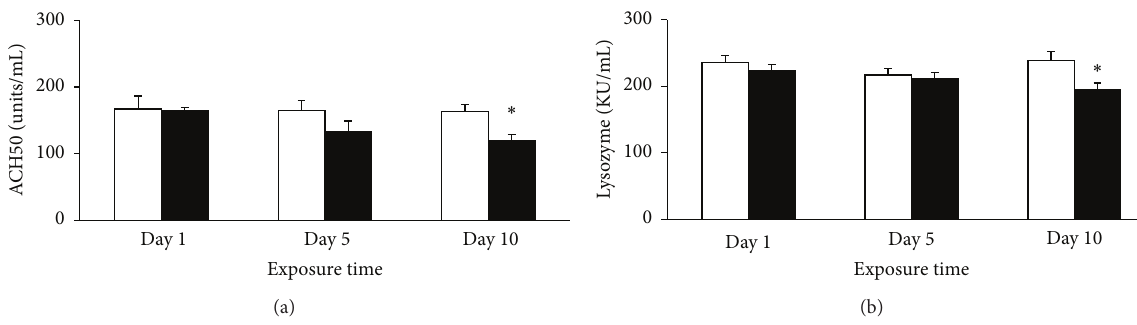
Figure 1: Plasma complement ACH50 (a) and lysozyme (b) activities of O. mykiss 1, 5, and 10 days after ip implantation of 5 𝜇 L/g body weight (bw) of coconut oil alone (control, open bars) and containing 50 𝜇 g/g bw cortisol (closed bars). Values represent the means and SEM ( 𝑛 = 6 per group). Significant differences are highlighted as ∗ versus control ( 𝑃 < 0.05 ).